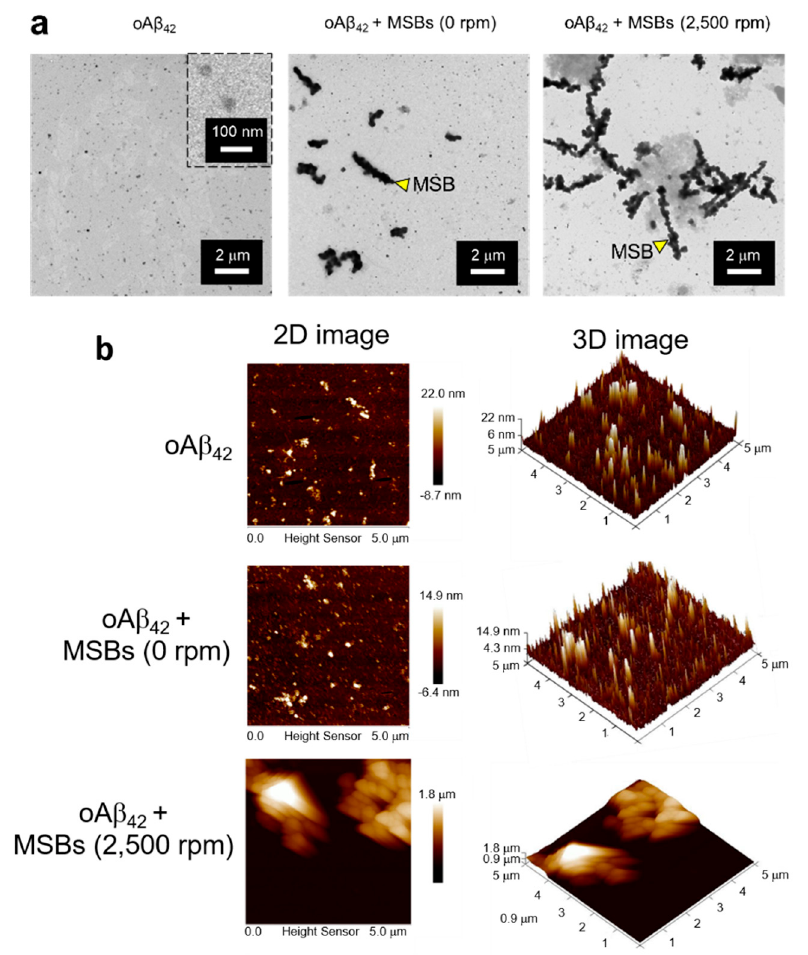
Figure 4. Structural analyses of oA β 42 and mpA β 42 by TEM and AFM. ( a ) TEM images of effective capture of oA β 42 into mpA β 42 via magnetic stirring. Scale bar: 2 μ m. ( b ) Examination of mpA β 42 by AFM. 2D topographic images of oA β 42 , oA β 42 + MSBs (0 rpm), and oA β 42 + MSBs (2,500 rpm); and 3D topographic representations of oA β 42 , oA β 42 + MSBs (0 rpm), and oA β 42 + MSBs (2,500 rpm).